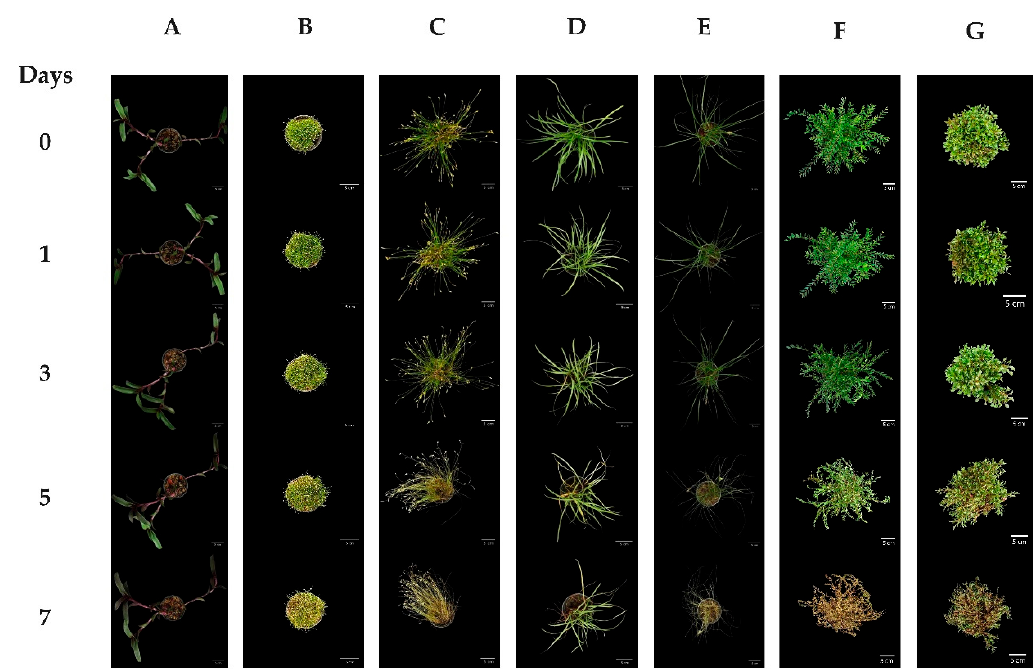
Figure A3. Images of plants under the drought treated condition at 5 times intervals:0, 1, 3, 5, and 7 days after of the start of the experiment,(Coreopsis rosea: A, Trachelospermum jasminoides: B, Acalypha wilkesiana,: C, Rhymchospora nervosa: D, Leucanthemum vulgare: E).